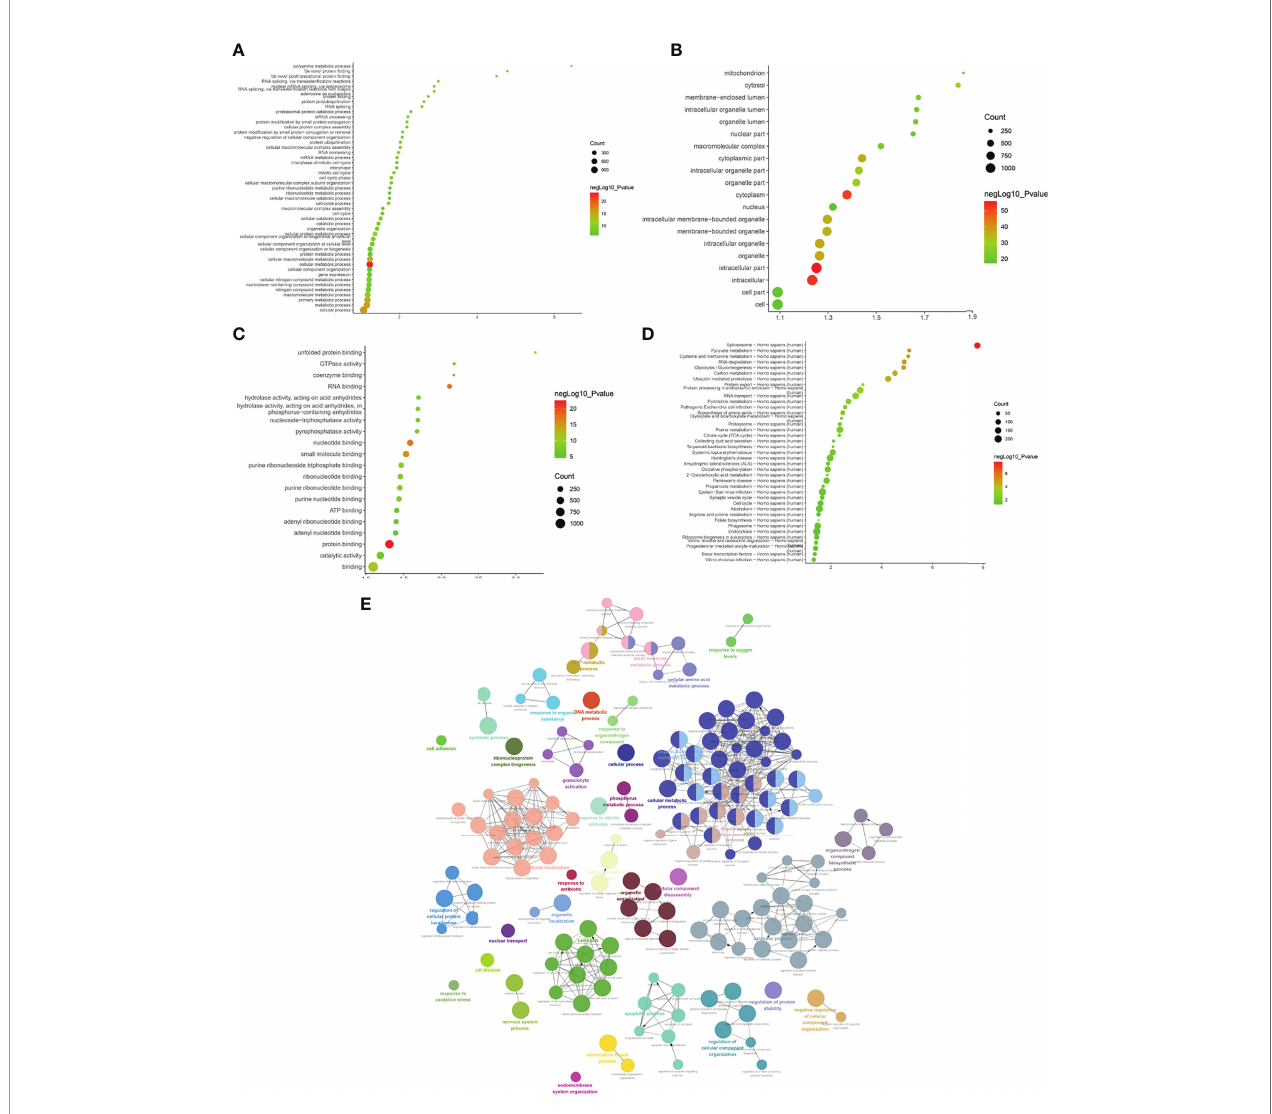
FIGURE 5 | Enrichment Analysis of down-regulated mRNAs [ (A) biological processes; (B) cell components; (C) molecular functions; X-axis stands for fold enrichment. (D) Signaling pathways; X-axis stands for enrichment score. (E) Enrichment